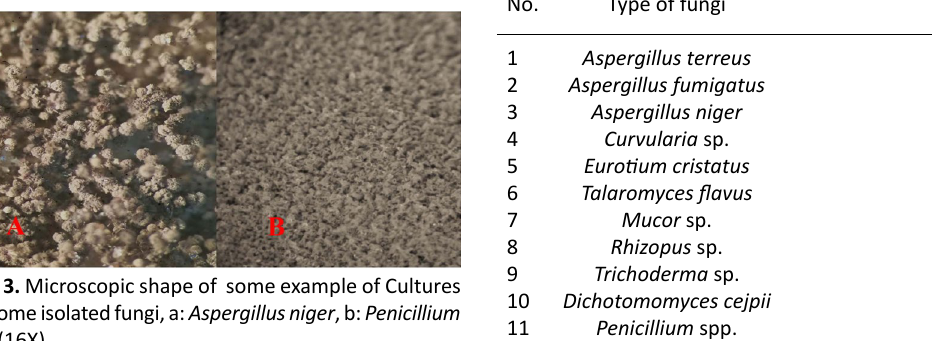
Table 7. Fungal species isolated from the sediments of studying station No.